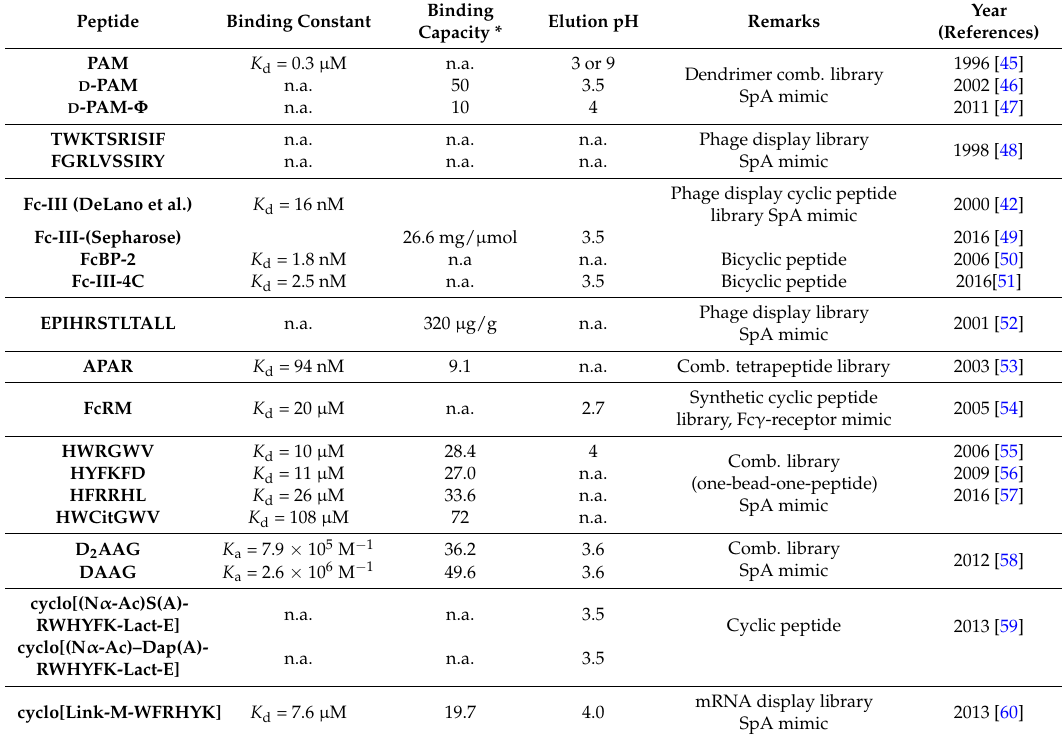
Table 2. A representable selection of high affinity (cyclic) peptides that selectively target immunoglobulin G.